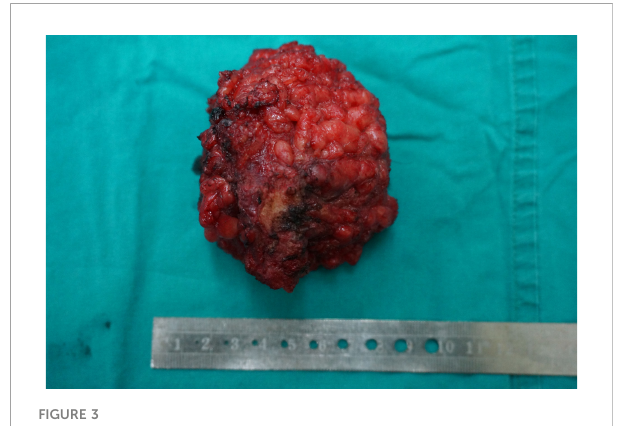
FIGURE 3 Macroscopic image of the resected